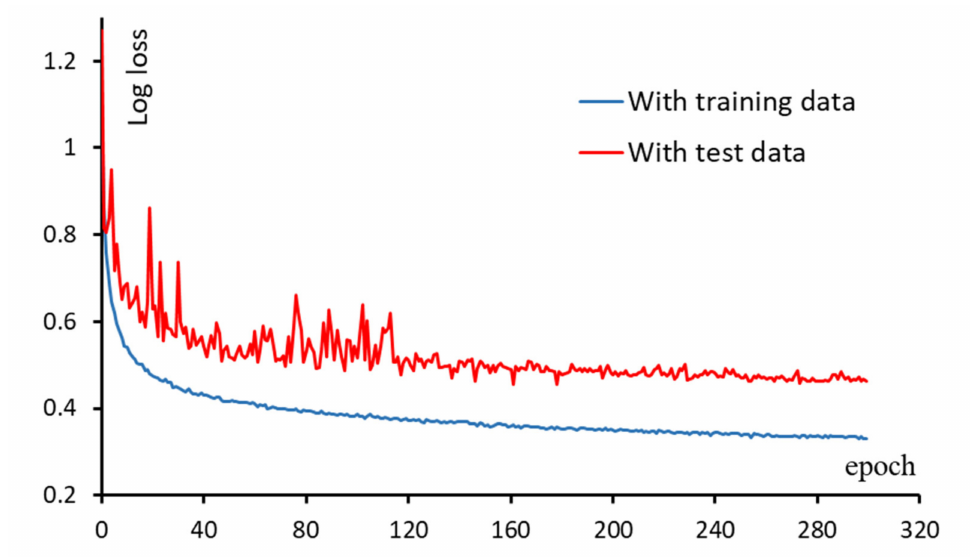
Figure 6. Variation of the loss value after 300 epochs.